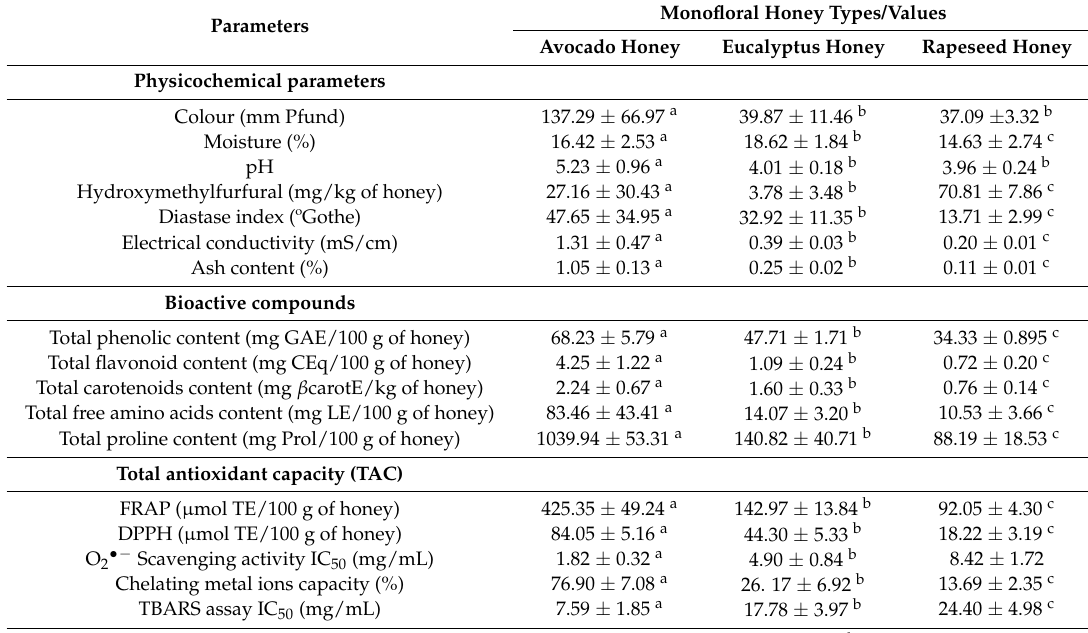
Table 1. Physicochemical parameters, bioactive compound and total antioxidant capacity in monofloral honeys from